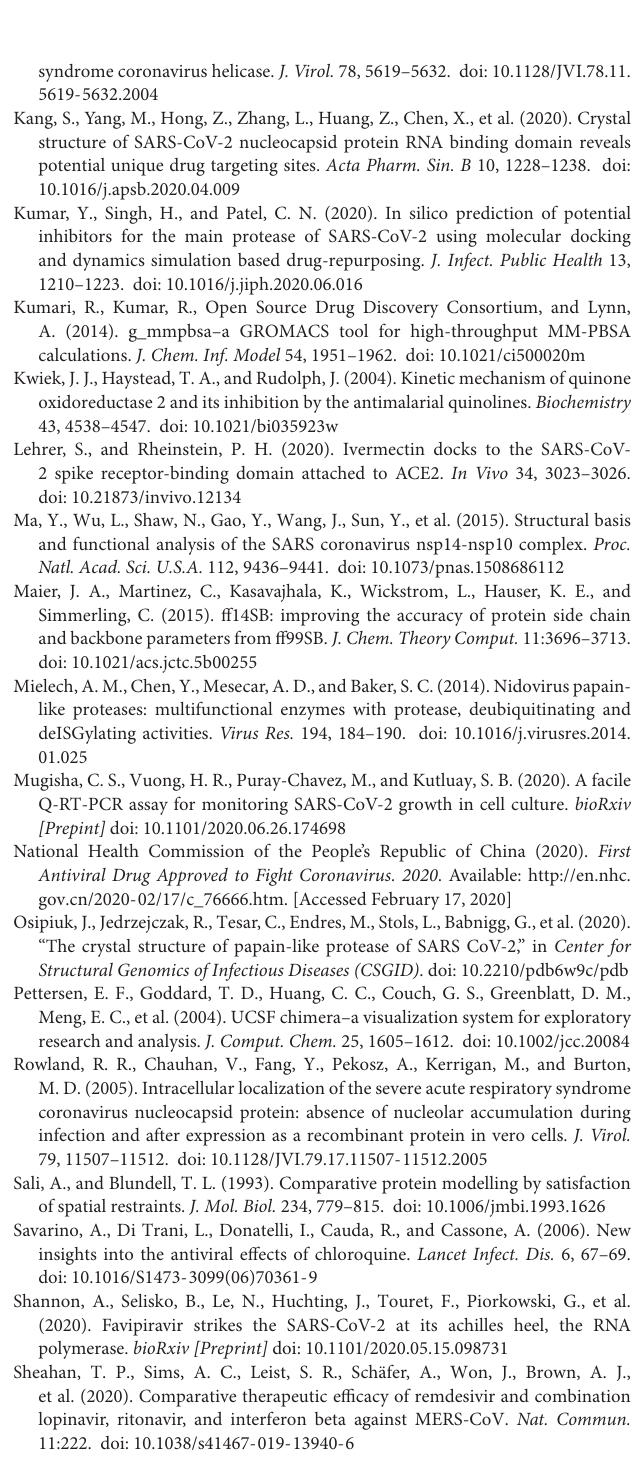
Supplementary Figure 1 | Chemical structure of FDA drugs used in the present study. Supplementary Figure 2 | Binding interactions of selected drugs with human ACE-2 protein and TMPRSS2 protein. (1) Binding interactions of selected drugs with human ACE-2 protein. (A) MLN-476, (B) chloroquine, (C) hydroxychloroquine, (D) ivermectin, (E) remdesivir, and (F) favipiravir. (2) Binding